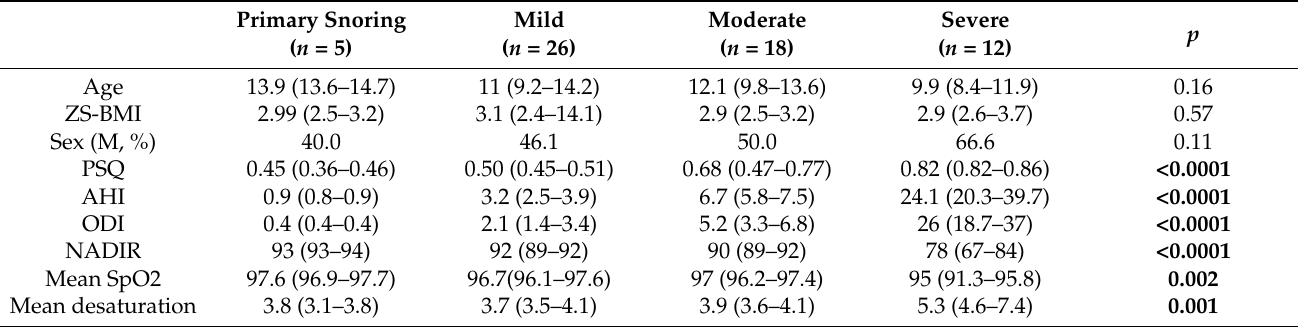
Table 3. Differences according to OSA